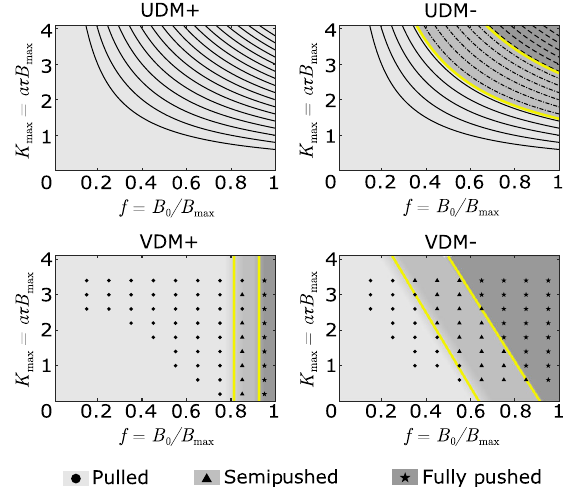
FIG. 10. Phase diagrams showing the expansion types for the four model variants as a function of f and K , β ¼ 20 max throughout. As can be seen by comparison to Fig. 3, the qualitative behavior of the transitions in each of the models remains the same, and can be characterized using the same variables: K s;p for the UDM − , f s;p for the VDM þ , and m s;p and a − . As before, lines in the UDMs and data points s;p for the VDM in the VDMs indicate the parameter combinations for which numerical integration is performed and velocities calculated. Transition boundaries (yellow lines) are inferred from the data points calculated.